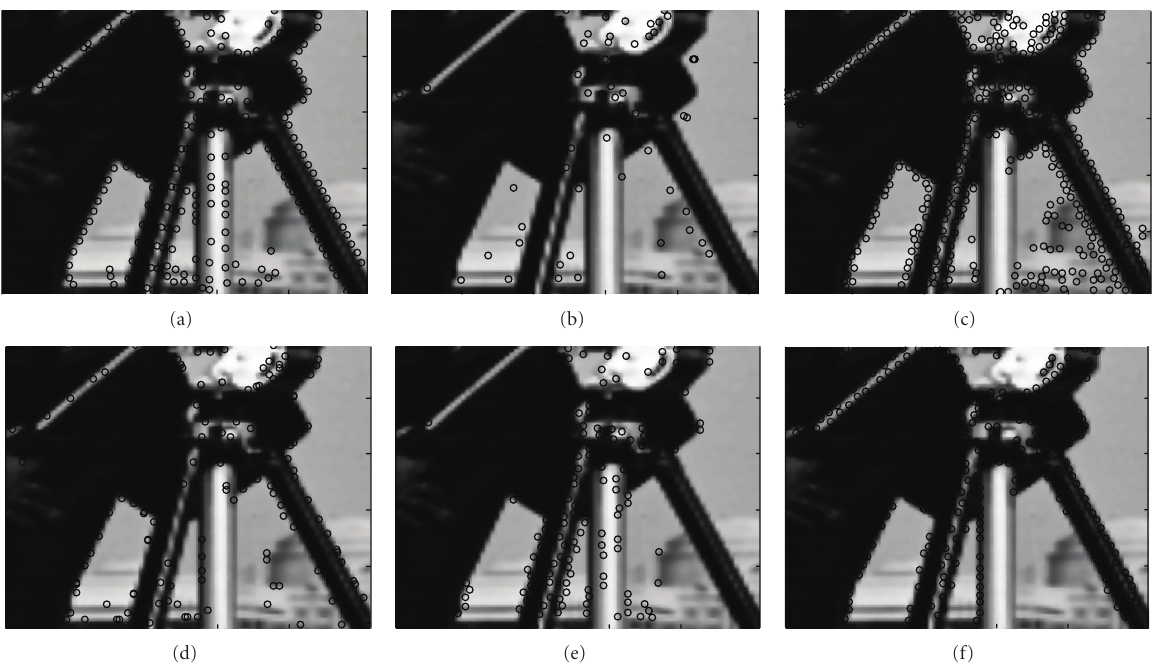
Figure 8: Feature points detected in 3.4 times scaled image by (a) Harris’ method, (b) Lowe’s method, (c) Tomasi’s method, (d) Loupias’ technique, (e) Yeh’s algorithm, and (f) proposed technique.